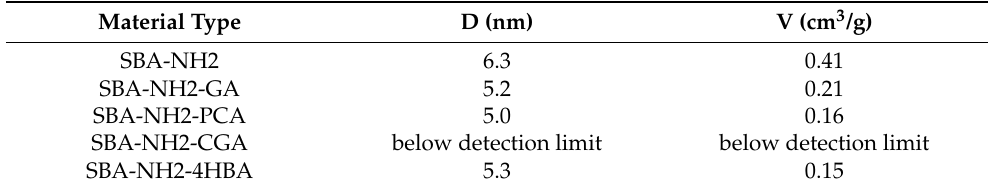
Figure 3. ( a ) Pore size distribution of parent and antioxidant-loaded SBA-NH2 materials based on H 2 O-TPM; ( b ) DSC thermograms of the SBA-NH2, SBA-NH2-GA, and GA reference samples. Table 3. The diameter and pore volume of parent and antioxidant-loaded SBA-NH2 derived from H 2 O-TPM.